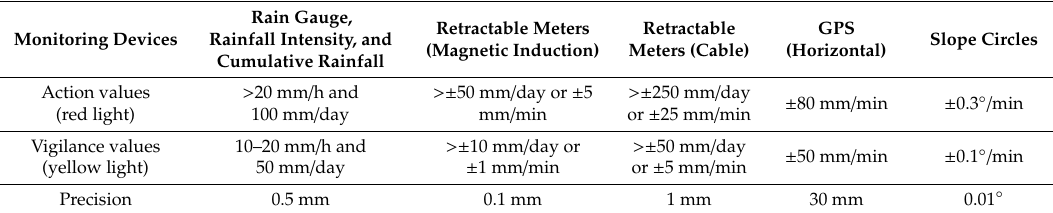
Table 4. Management values of the monitoring devices